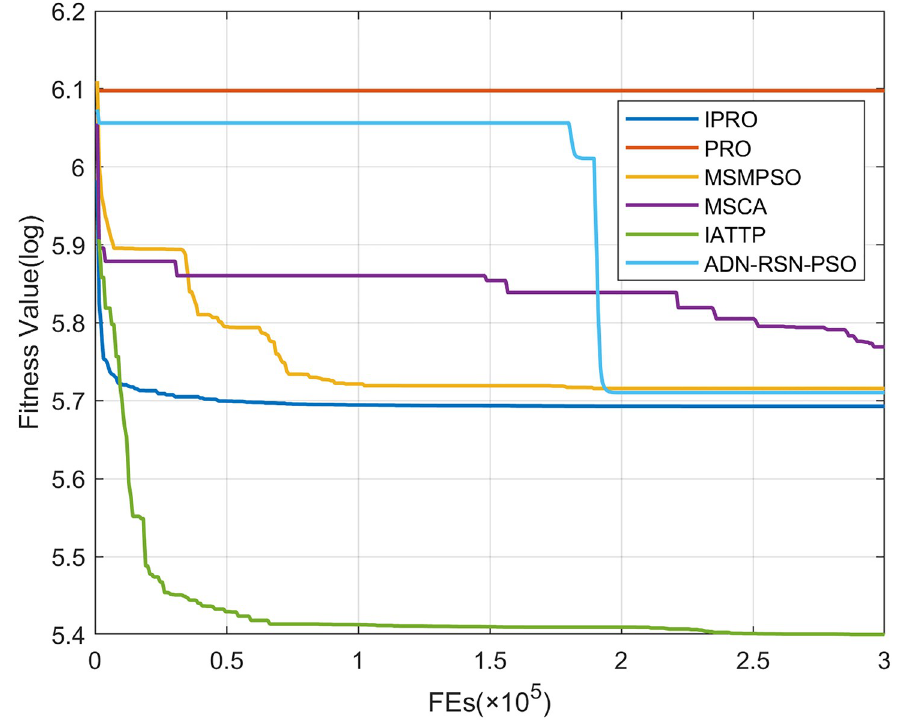
Fig 25. Convergence curves on F25.